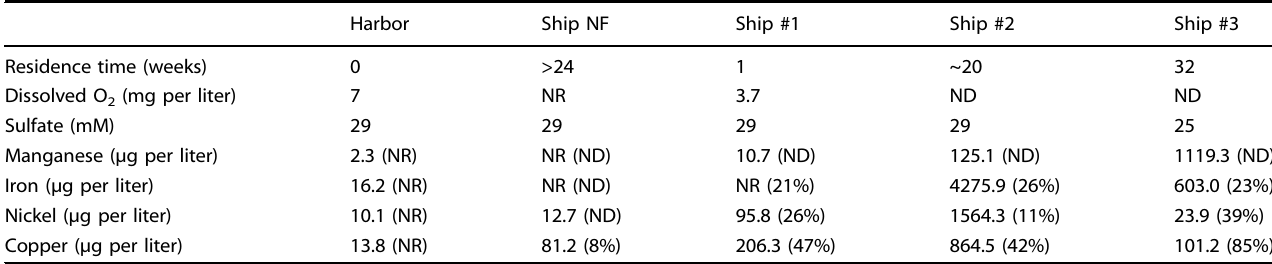
Table 1. Summary of water sample residence times (reported or estimated from shipboard personnel) and selected chemical properties.